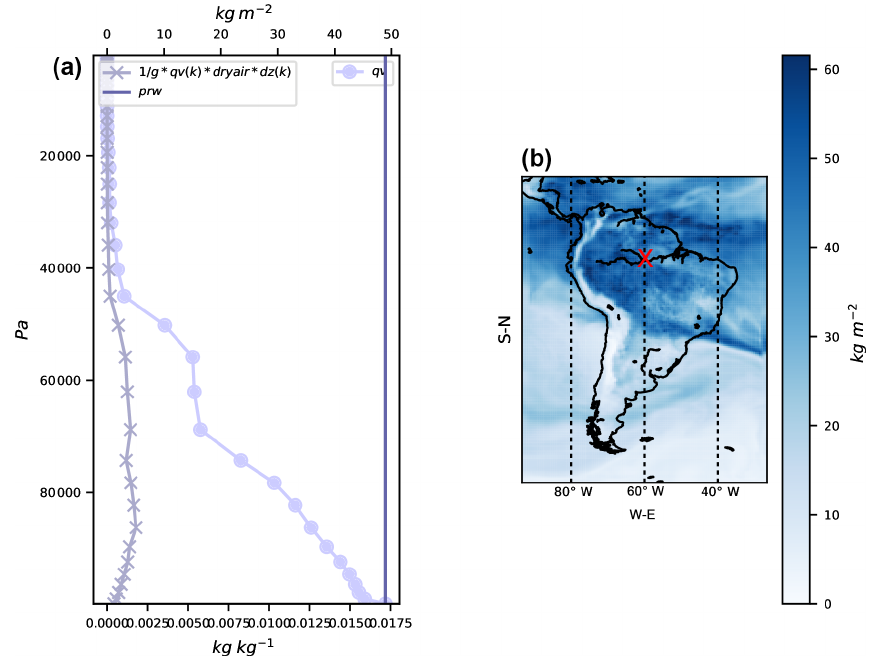
Figure 7. On 9 December 2012 at 15:00UTC at 62 ◦ 4 (cid:48) 38.00 (cid:48)(cid:48) S, 4 ◦ 58 (cid:48) 55.51 (cid:48)(cid:48) W: (a) water path (prw, vertical straight line in millimeters top x axis), vertical profile of water vapor (qv, line with full circles in kgkg − 1 bottom x axis), and water path at each level (line with crosses). Map of water path (b) on 9 December 2012 at 15:00UTC; red cross shows where the vertical accumulation is retrieved.